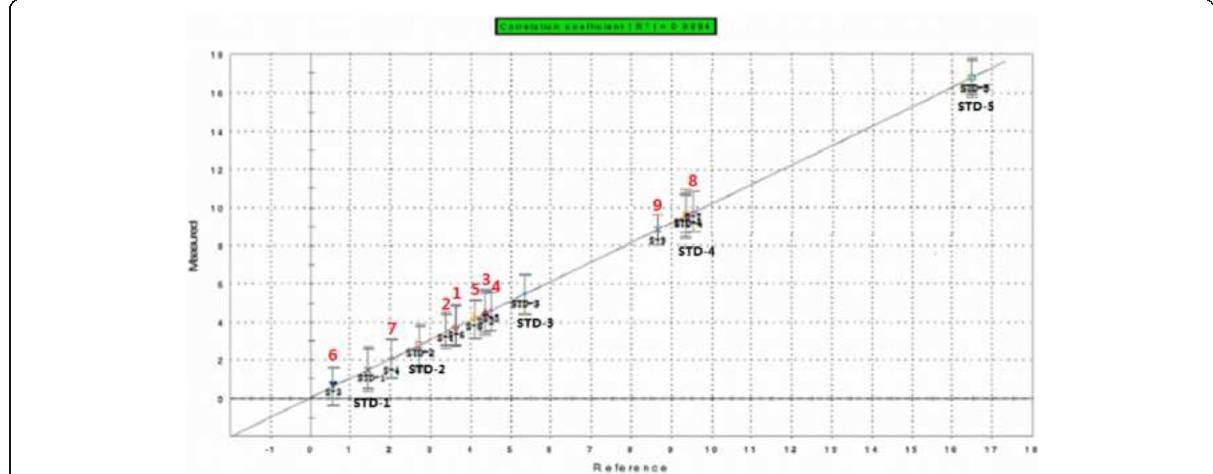
Fig. 4 Partial least squares (PLS) analysis by